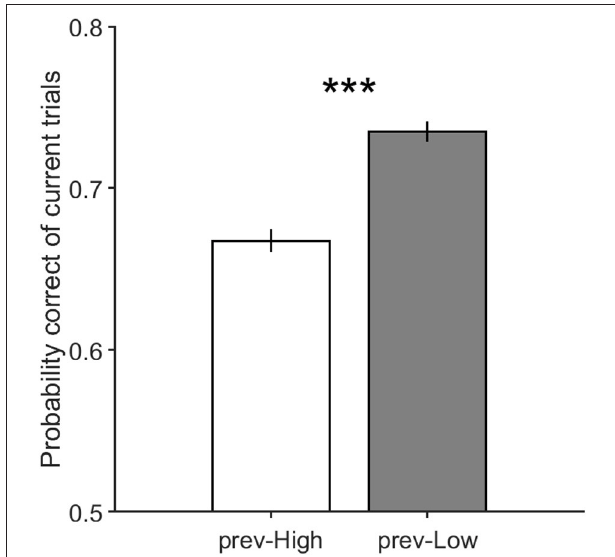
FIGURE 4 | The performance of the current trials which includes motion strengths of 3.2, 6.4, and 12.8% when their previous trials have high motion strengths of 12.8, 25.6, and 51.2% in prev-High, and have low motion strengths of 0 and 3.2% in prev-Low. Error bars indicate SE (Standard Error). Wilcoxon rank-sum test is used to test the significance of the difference, *** p < 1E −